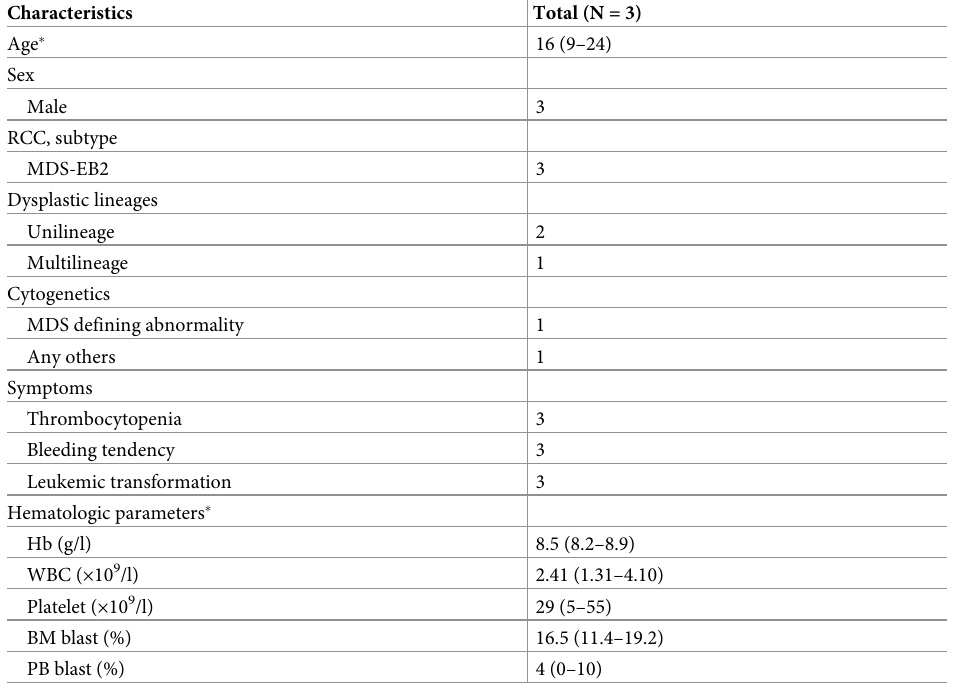
Table 1. Clinical characteristics and laboratory findings of three patients with refractory cytopenia of childhood.